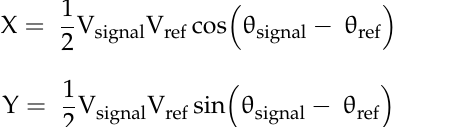
The amplitude and phase of the signal of interest can be finally given by Equations (17) and